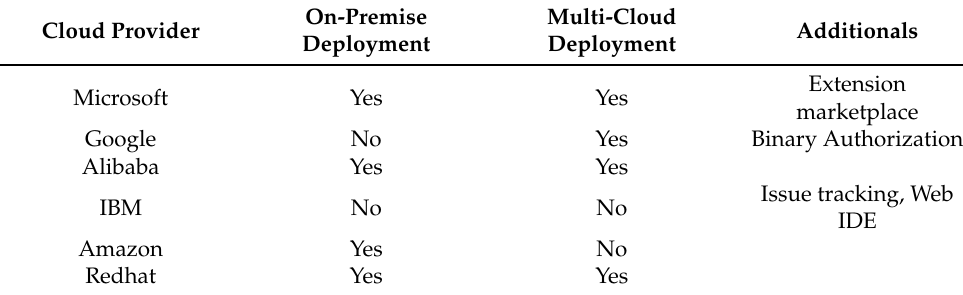
Table 1. Comparison of cloud